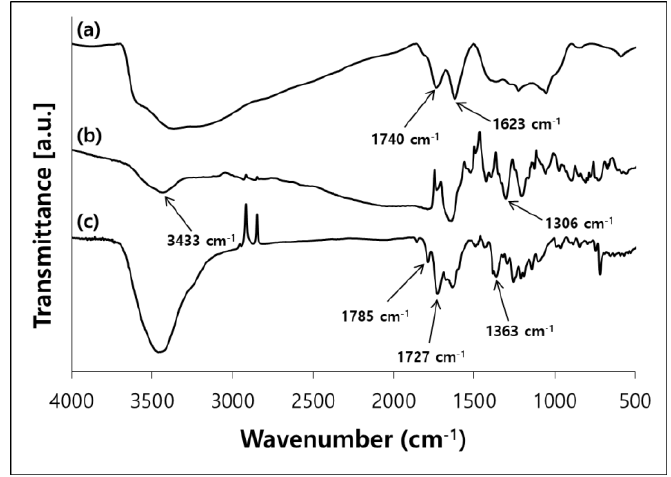
Figure 1. Schematic illustrations of the synthesis of ( a ) AnDA-GO and ( c ) PI-GO; ( b ) FE-SEM images of the GO and AnDA-GO; ( d ) Chemical structures of AnDA, DAn, PAA and PI.